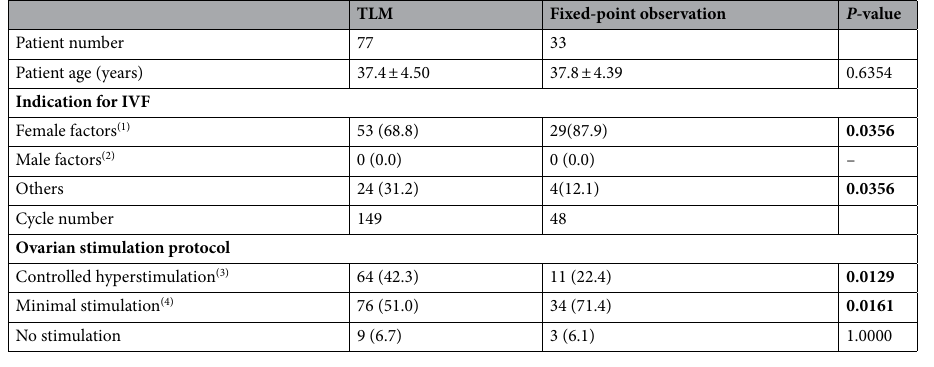
Table 1. Patient characteristics and ovarian stimulation protocol. (1) Female factors include women with ovulation disorders, tubal factors, and uterine anomalies, or otherwise unexplained infertility. (2) All patients who had a male factor were indicated for ICSI. (3) Controlled hyperstimulation was based on recombinant follicle-stimulating hormone injections and nasal gonadotropin-releasing hormone agonist sprays. (4) Minimal stimulation was based on oral clomiphene citrate tablets. Age is shown as the mean ± standard deviation, and all other data are shown as number (percentage). IVF in vitro fertilization; PN pronuclei; TLM time-lapse